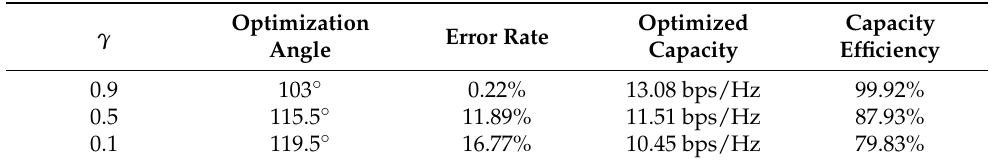
Table 6. Optimized values for antenna downtilt and channel capacity with different discount rates at D = 100 m.